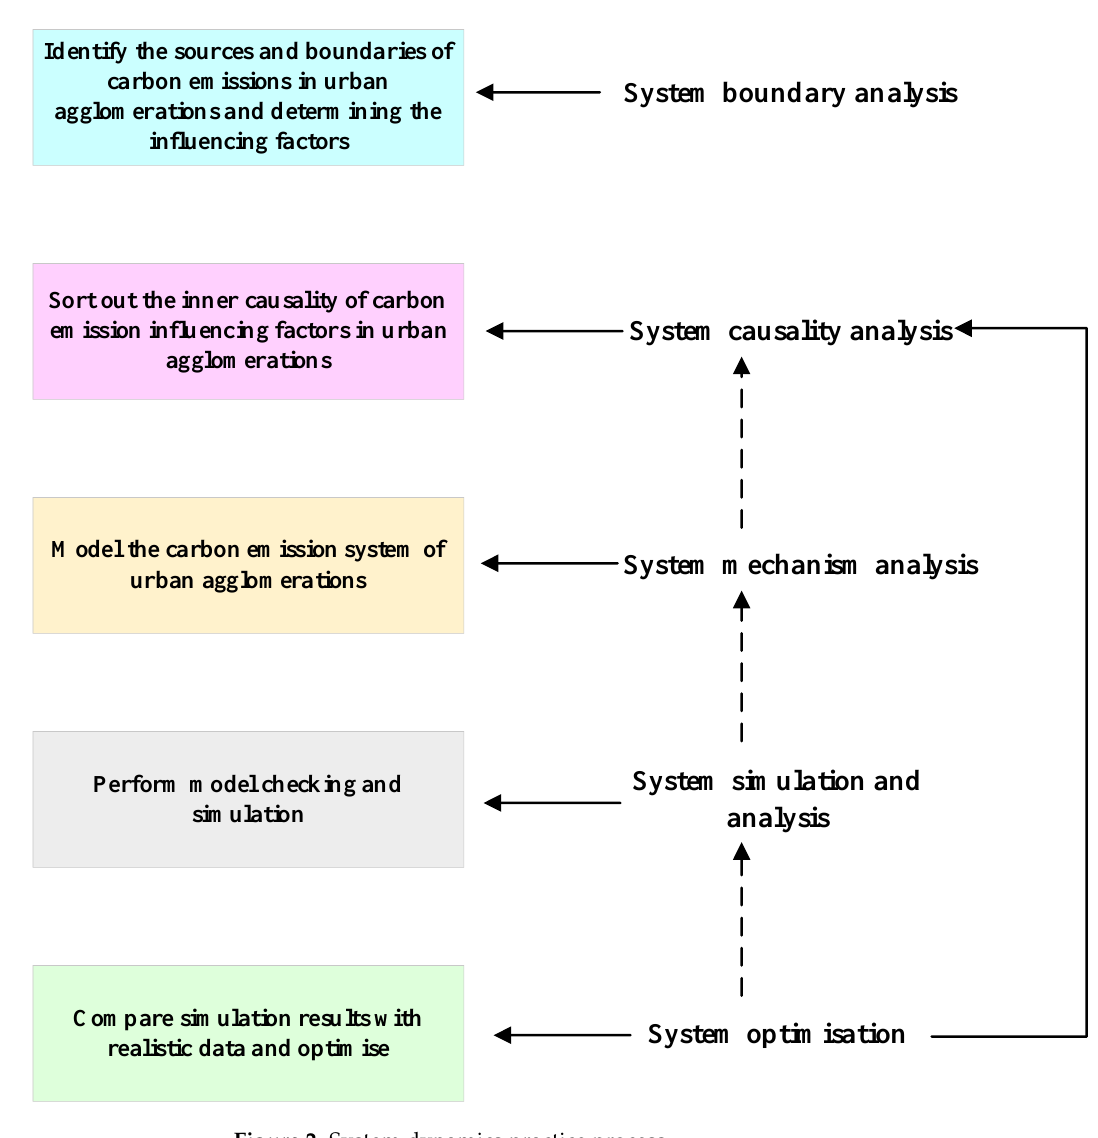
Figure 2. System dynamics practice process.